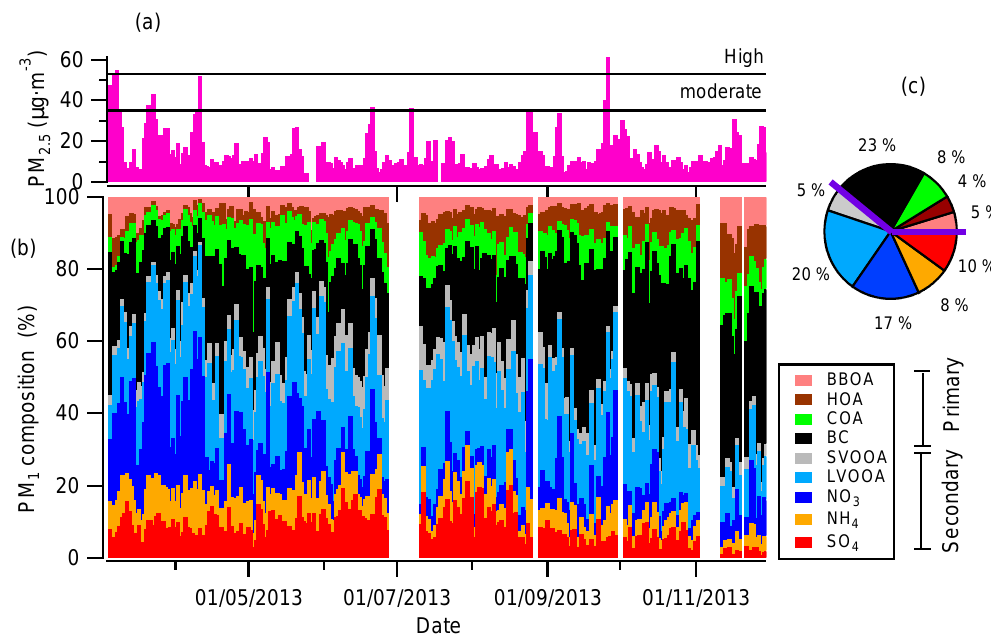
Figure 6. (a) Daily PM 2 . 5 concentrations, (b) daily and (c) total PM 1 composition, purple line in Fig. 6c separates secondary and primary